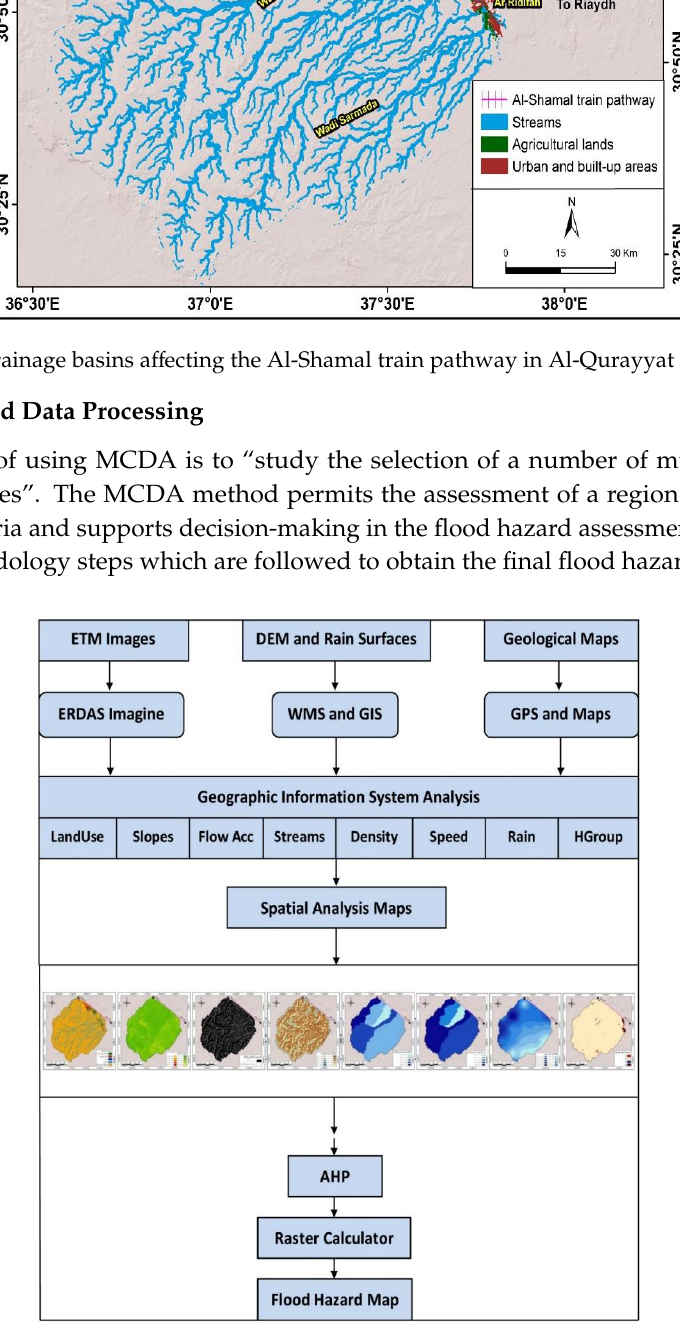
Figure 4. Methodology and data processing.